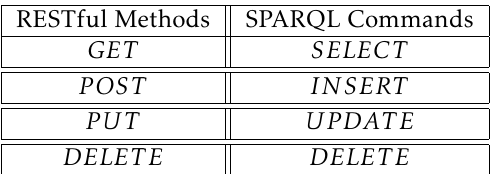
Table 1. MappingRESTfulmethodsto SPARQLcommands RESTful Methods